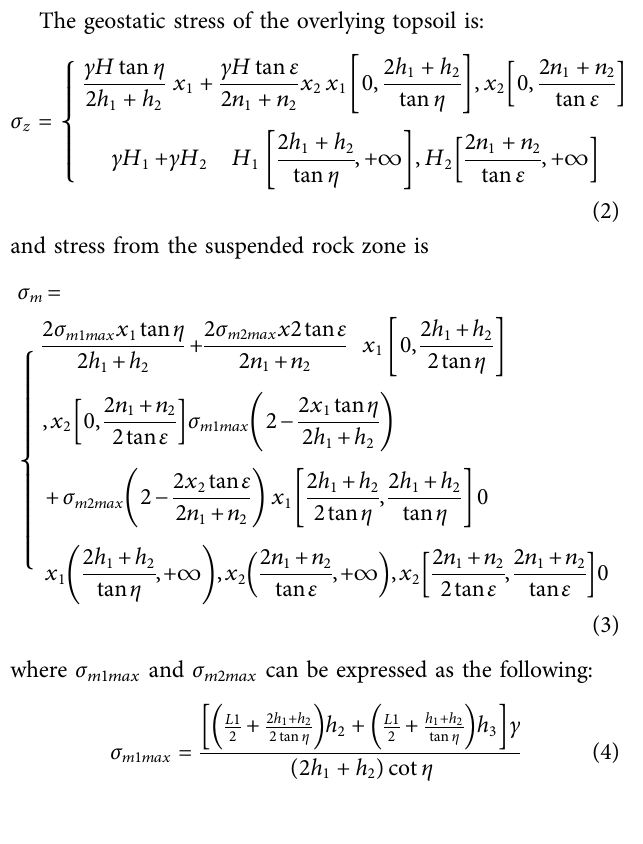
Frontiers in Earth Science |